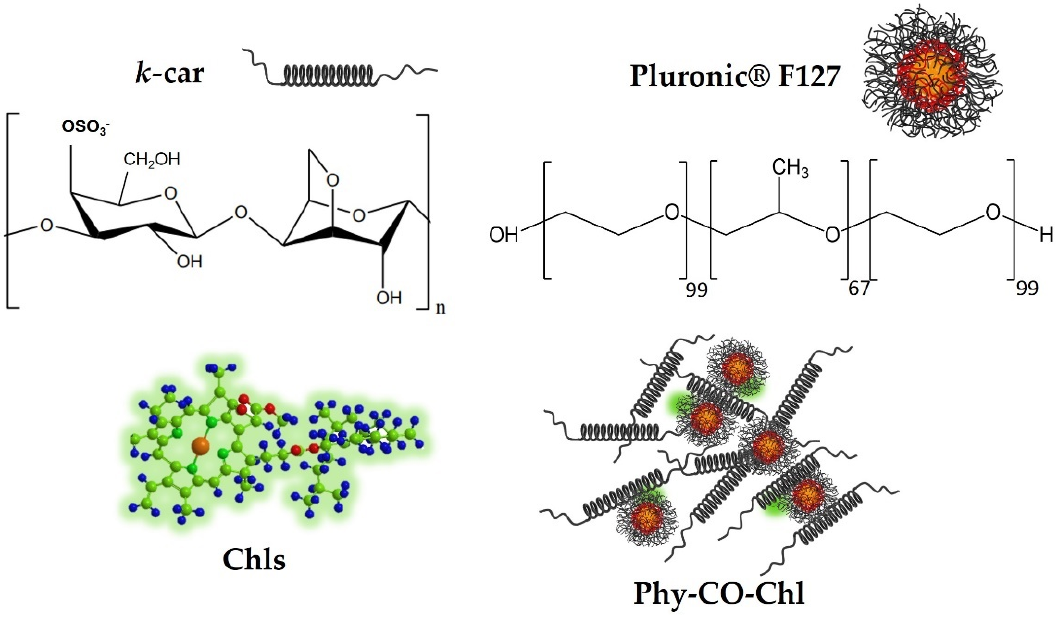
Figure 1. Obtaining the formulation composed of k- car, F127, chlorophylls, and CO, making up the Phy-CO-Chl emulgel. Phy-CO-Chl